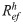
Estimation of Model TMAL in Period 3 (October/2004—September/2008).(a) observed incidence (O) and adjusted i (E), (b) m3/m, (c) Refh (h) and Refm (m), and (d) Ref=Refh×Refm.